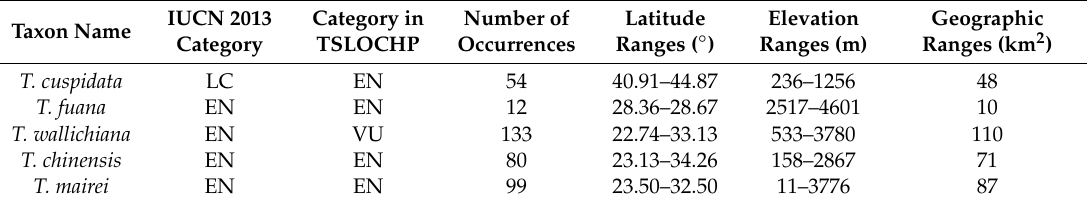
Table 1. Conservation status of five Taxus species in the IUCN Red List and Threatened Species List of China’s Higher Plant, and number of each species